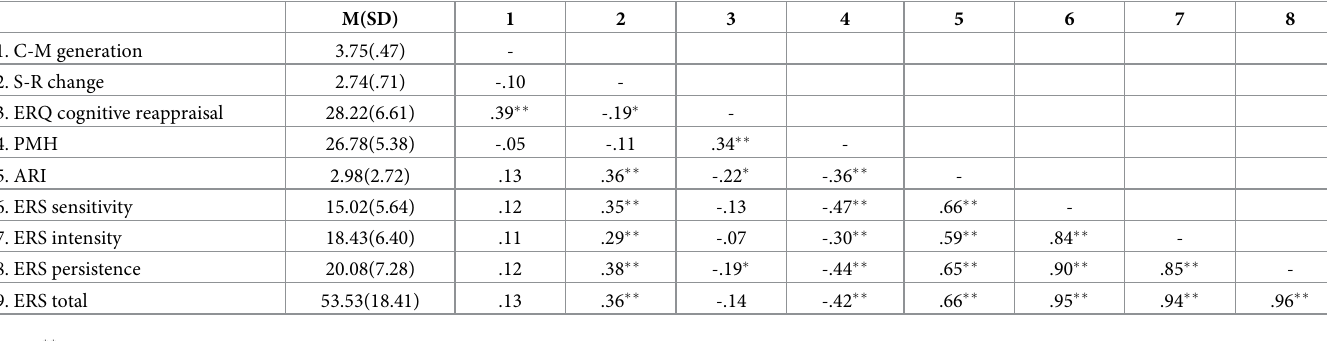
Table 3. Study 3 Pearson’s correlation